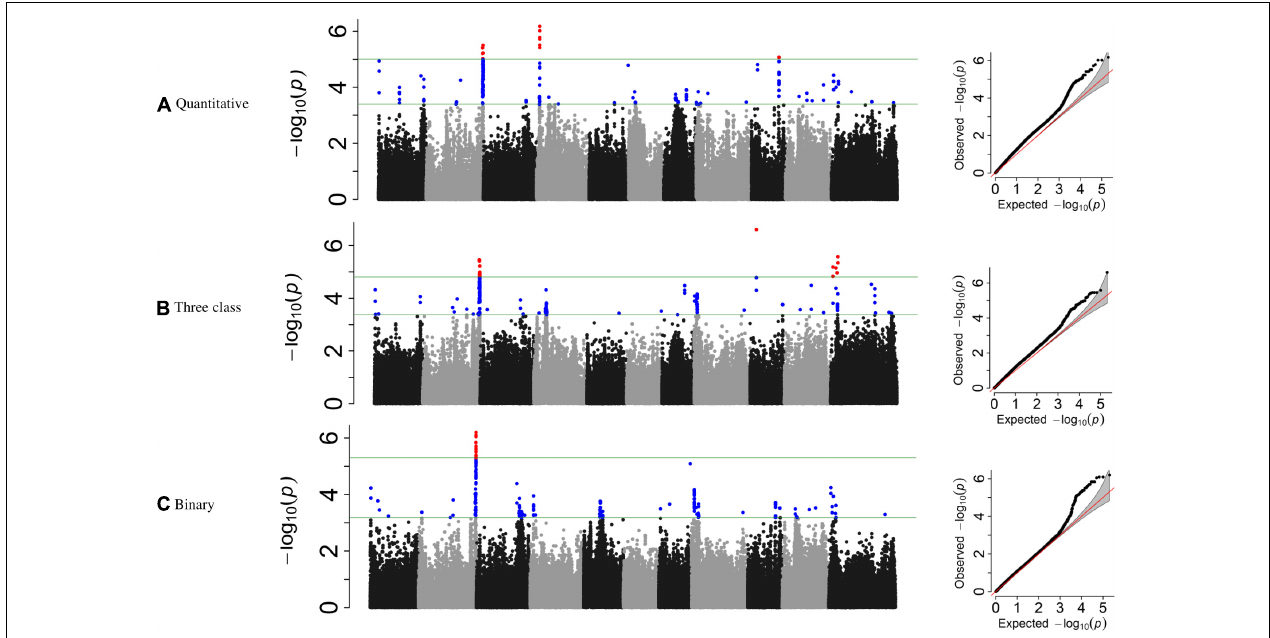
FIGURE 3 | Manhattan plots and corresponding QQ-plots from GWAS analysis of (A) quantitative, (B) three-class, and (C) binary scoring systems in the ADP.